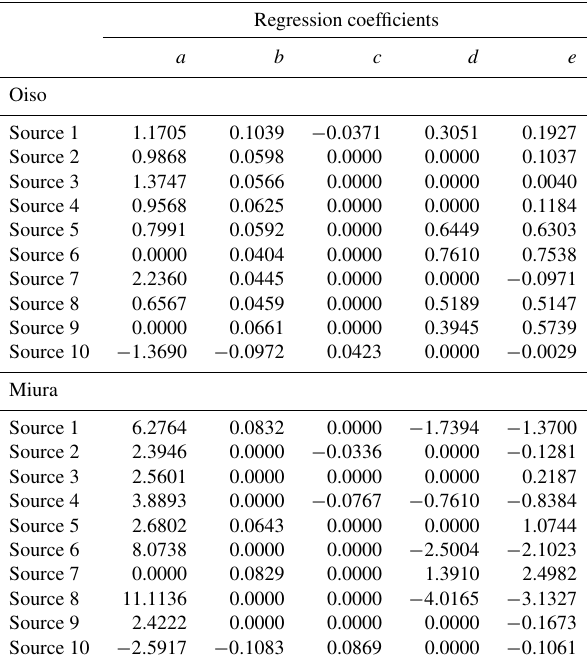
Table 4. Regression coefficients of each selected response surface for each earthquake source.